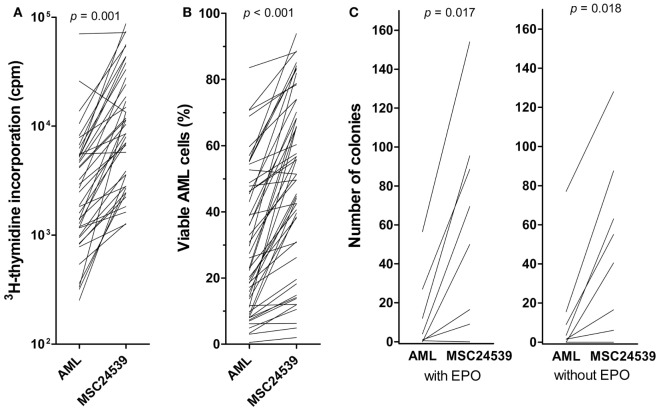
The effects of mesenchymal stem cells (MSCs) on acute myeloid leukemia (AML) cell proliferation/viability in suspension cultures and AML cells tested in a clonogenic assay. The effect of MSCs on the in vitro proliferation [(A), left] and viability [(B), middle] of primary human AML cells derived from 51 consecutive patients was examined. The AML cells were then cocultured with normal MSC24539. The MSCs were initially cultured for 3 days to allow them to establish adherent in vitro proliferation; primary human AML cells were thereafter added and (A) leukemia cell proliferation was assayed as 3H-thymidine incorporation after additional 3 days of culture; additionally, (B) AML cell viability was assayed by the Annexin V-PI flow cytometric assay. The p-values for the statistical comparison of the overall results are given at the top of the figure. Each line represents the results for one patient. [(C), right] The effects of MSCs on clonogenic AML cells were also investigated. The leukemic cells were cultured either in medium alone or in transwell cocultures together with MSC24593 for 3 weeks; the number of clonogenic cells were thereafter compared for AML cells precultured in medium alone and together with MSCs. The total culture period was thus 5 weeks. The MSCs significantly increased the number of colony-forming units (p-values are given on top of the figure) in growth media both with and without erythropoietin. The results are presented as mean of duplicate samples (average deviation from mean corresponding to 1.3 colonies and 8.7% of the total colony number). Each line represents the results for one patient.